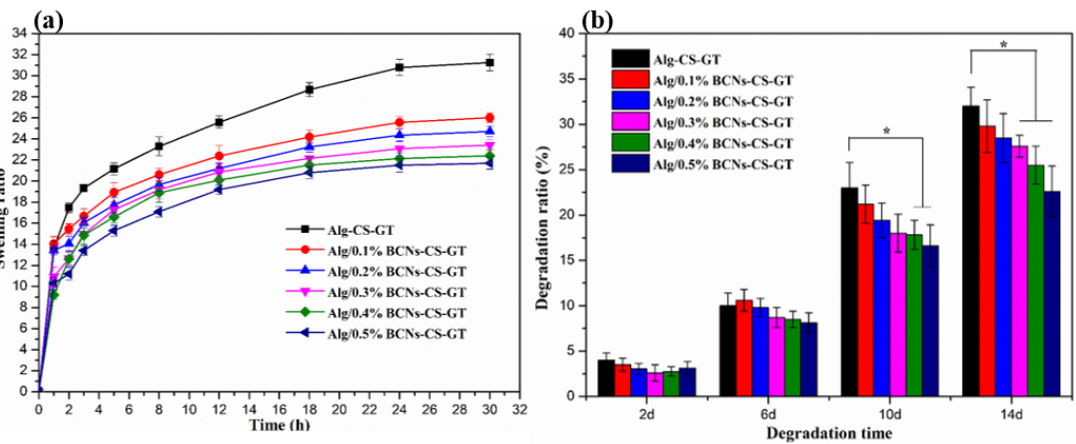
Figure 6. ( a ) Swelling curves of composite scaffolds in PBS at 37 °C; ( b ) in vitro biodegradability of composite scaffolds in PBS containing 10,000 U/mL lysozyme. * represents p < 0.05, indicating significant difference.